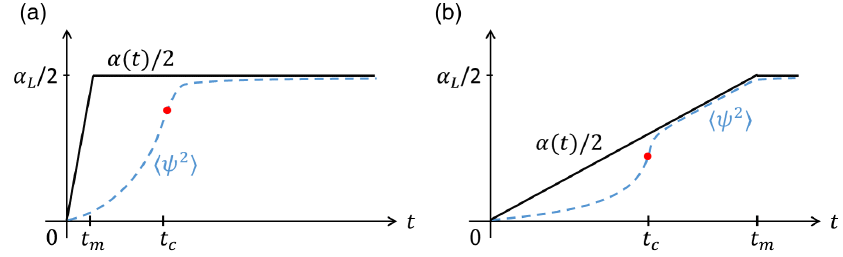
FIG. 9. Illustration of the evolution of order parameter fluctuation in (a) the fasting cooling case and (b) the slow cooling